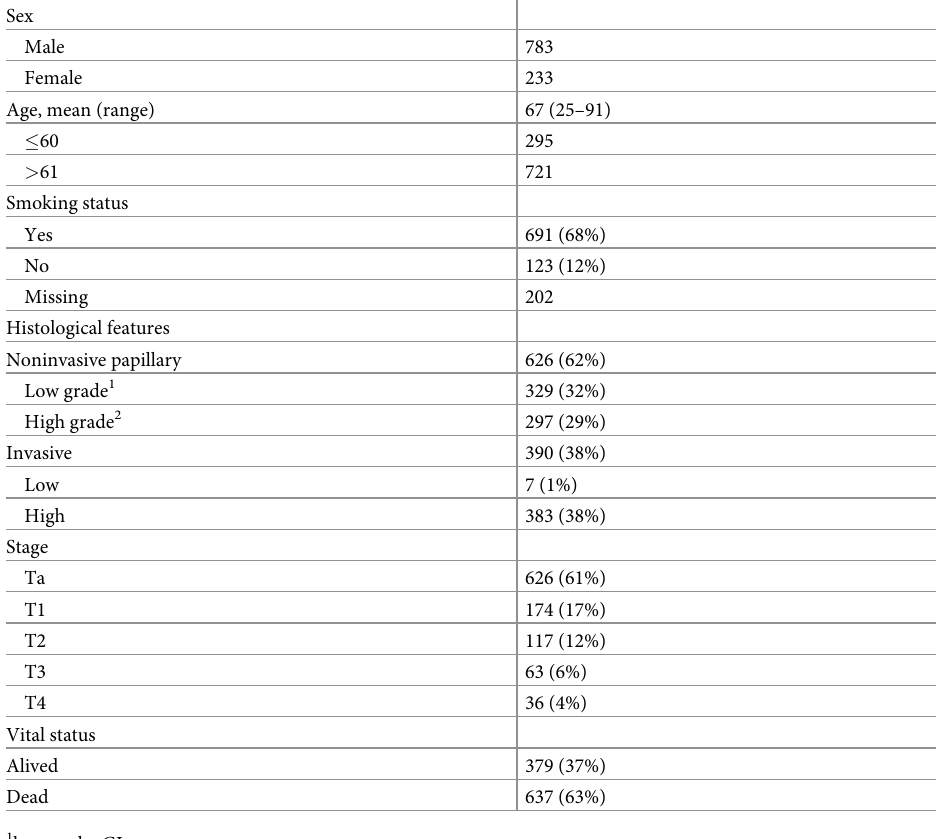
Table 1. Characteristics of the study population of bladder cancer (n =